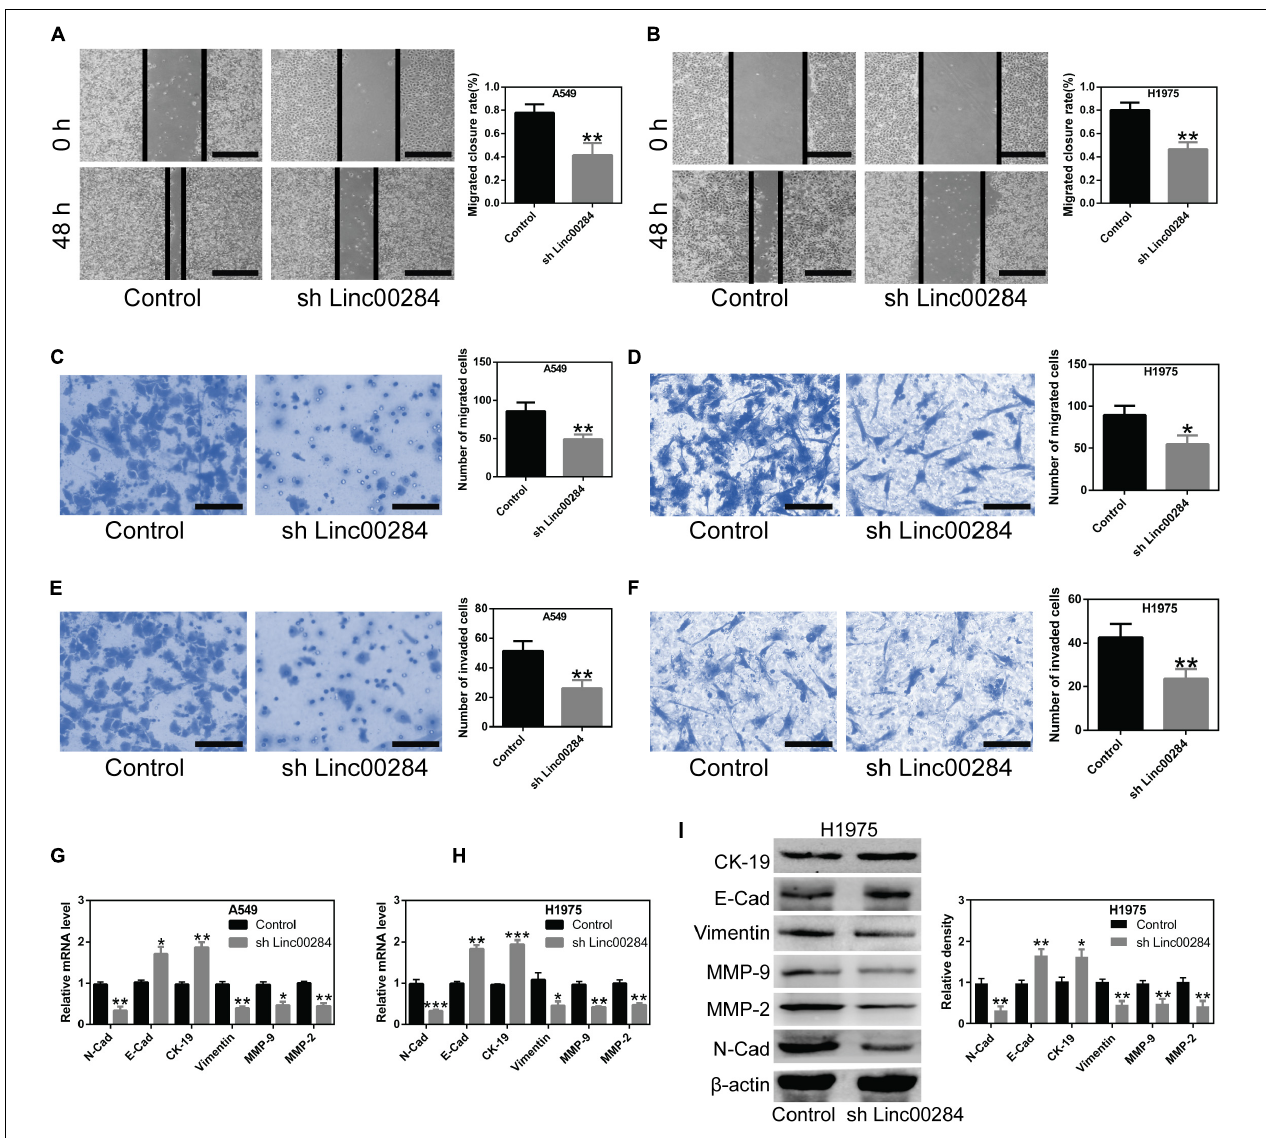
FIGURE 3 | Linc00284 silencing suppresses lung cancer cell migration and invasion. (A,B) Representative images and statistical results of migratory ability of Linc00284-silenced (A) A549 and (B) H1975 cells as determined by wound healing assays. Magnification, × 4. (C,D) Transwell migration assay was performed to examine migratory ability of Linc00284-silenced (C) A549 and (D) H1975 cells. Magnification, × 40. (E,F) Transwell invasion assays were performed to detect invasive capabilities of Linc00284-silenced (E) A549 and (F) H1975 cells. Magnification, × 40. (G,H) mRNA levels of EMT-related genes in (G) A549 and (H) H1975 cells. (I) Protein expression of EMT-related genes in H1975 cells. Data were analyzed using unpaired t -test and are expressed as the means ± SD for triplicate independent experiments. * P < 0.05, ** P < 0.01, and *** P < 0.001, compared with the matched control cells. EMT, epithelial-mesenchymal transition.